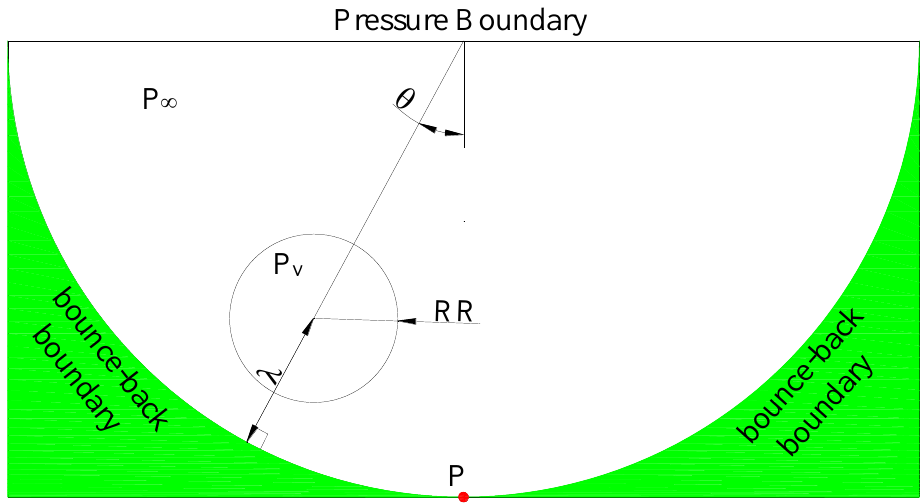
Figure 4. Simulated layout for Cases 1–4 (RR is the initial radius of bubble, λ is the distance between the center of the bubble and the concave wall, Pv is the vapor pressure, P∞ is the ambient pressure, θ is the angel to the vertical, and P is the center point at the concave wall).